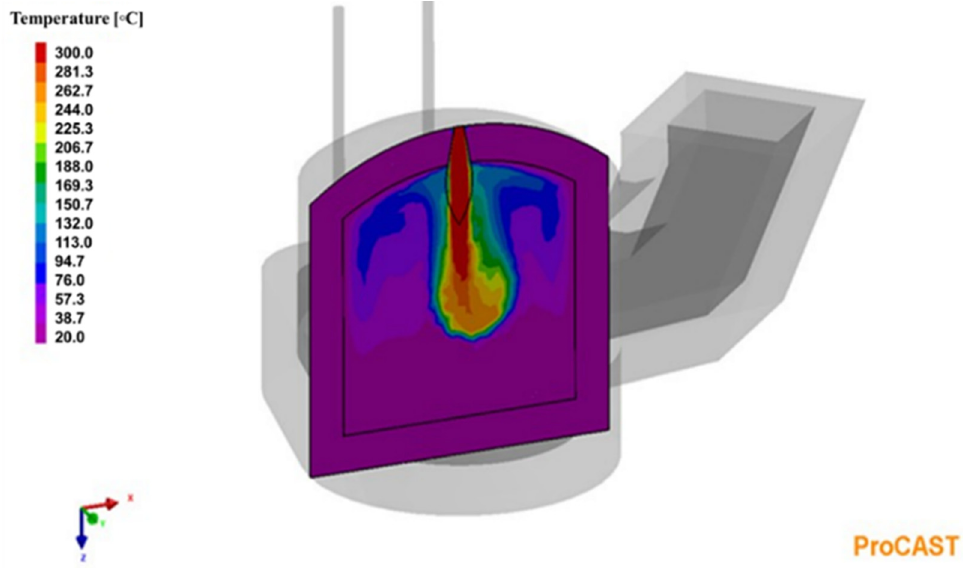
Figure 3. Temperature profile of the gases within the main chamber, after 869 s of simulation.